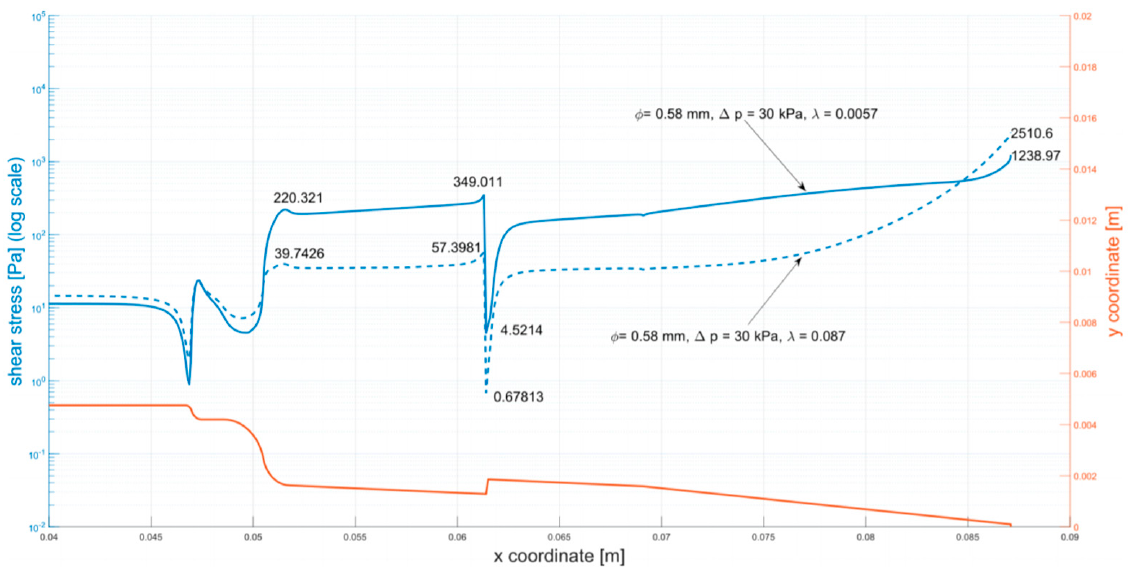
Figure 5. Shear stress at the walls of the cartridge ( ϕ = 0.58 mm, ∆ p = 30 kPa) . The analyzed parameters ( ϕ = 0.58 mm, ∆ p = 30 kPa) were selected as the maximum parameters for bioprinting with biological material. Analogous simulations were carried out for all tested systems, that is: ϕ = 0.2 mm, ∆ p = 30 kPa; ϕ = 0.2 mm, ∆ p = 50 kPa; ϕ = 0.2 mm, ∆ p = 100 kPa; ϕ = 0.58 mm, ∆ p = 50 kPa; ϕ = 0.58 mm, ∆ p = 100 kPa (Appendix A: Figures A1–A5).